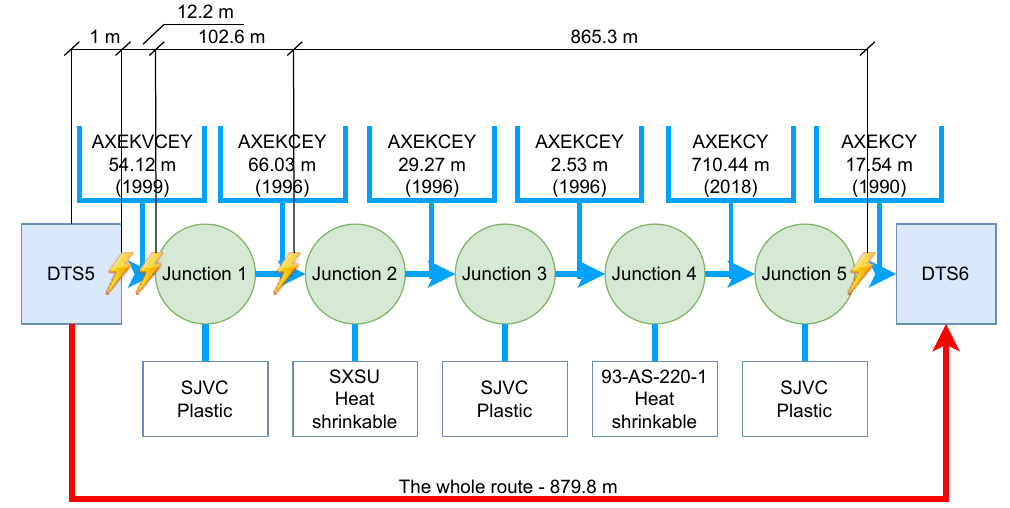
Figure 5. Measurement of the whole longest route showing cable types, junction types and measure- ments indicating partial